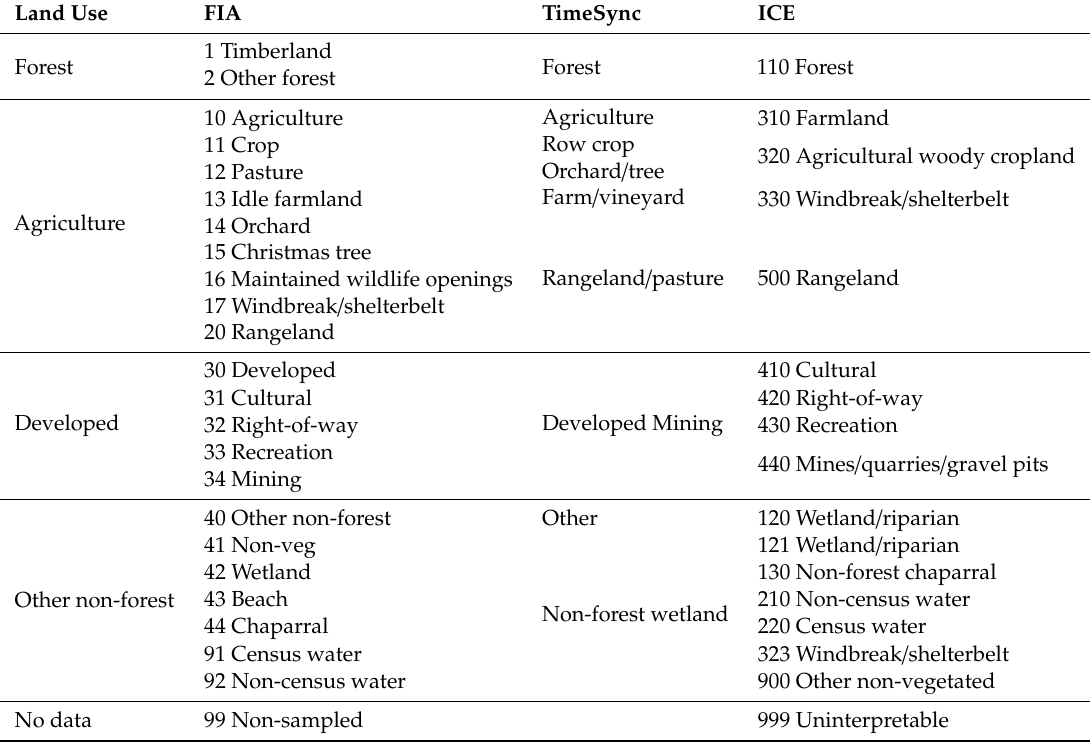
Table A1. Crosswalk of land use categories to four broad groups used for analyses.